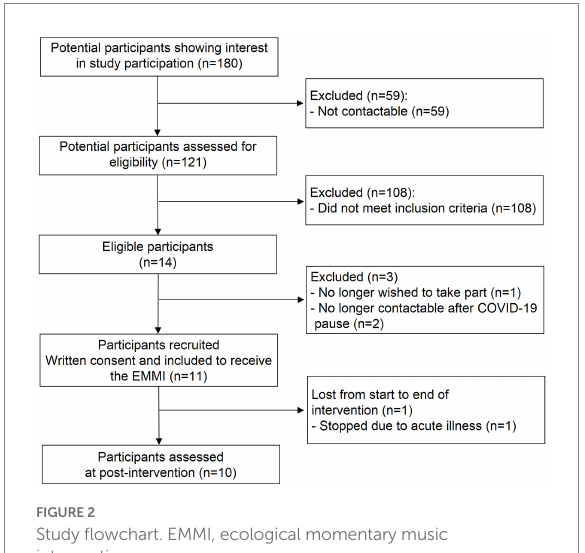
FIGURE 2 Study flowchart. EMMI, ecological momentary music